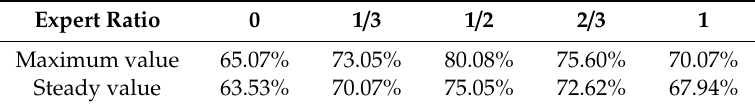
Table 7. Prediction accuracy of the layer